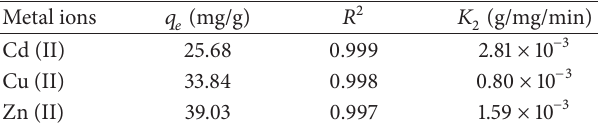
Table 2: Sorption kinetics of pseudo second order for metal ions. Metal ions